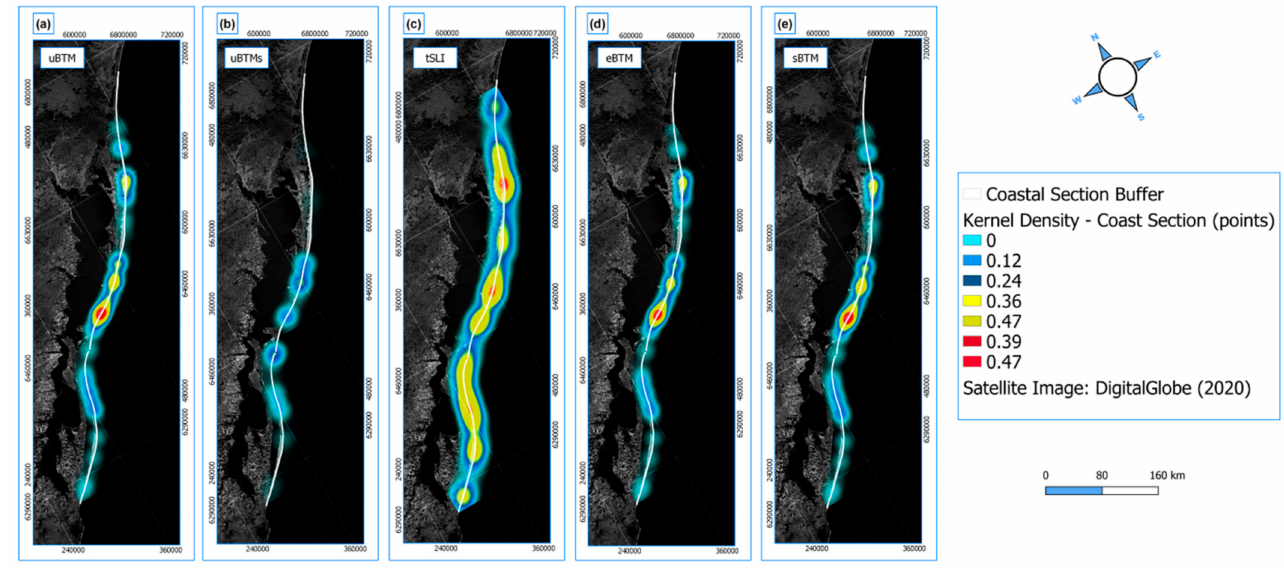
Figure 8. Spatial distribution with Kernel Density on coastal section. ( a ) Uncertainty Bathtub model (uBTM). ( b ) Uncertainty Bathtub model smoothed (uBTMs). ( c ) Terrset sea-level impact (tSLI). ( d ) Enhanced Bathtub model (eBTM). ( e ) Simple Bathub model (sBTM).